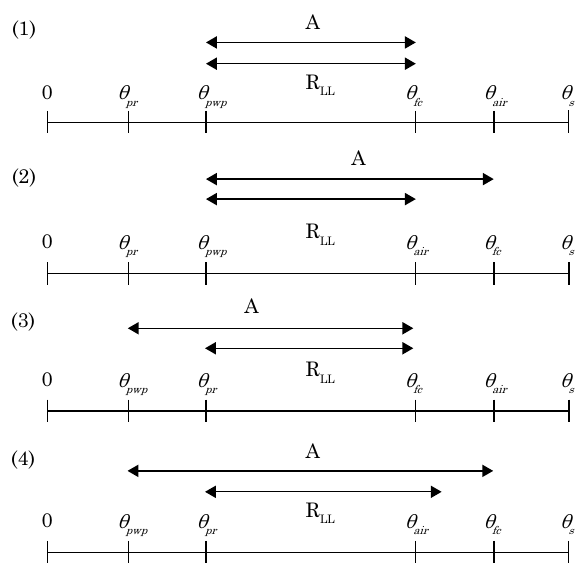
Figure 1. Least Limiting Water Range ( r ll ) and available water ( A ) on a scale of volumetric water contents from completely dry (0) to saturation ( θ s ), according to equations 1 and 2 for the four possible combinations of the relative position of water contents of permanent wilting and limiting root penetration resistance ( θ pwp and θ pr ) and of water contents of limiting air-filled porosity and field capacity ( θ air and θ fc